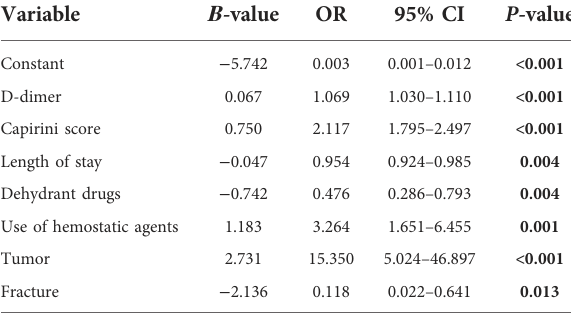
TABLE 3 Logistic regression model.